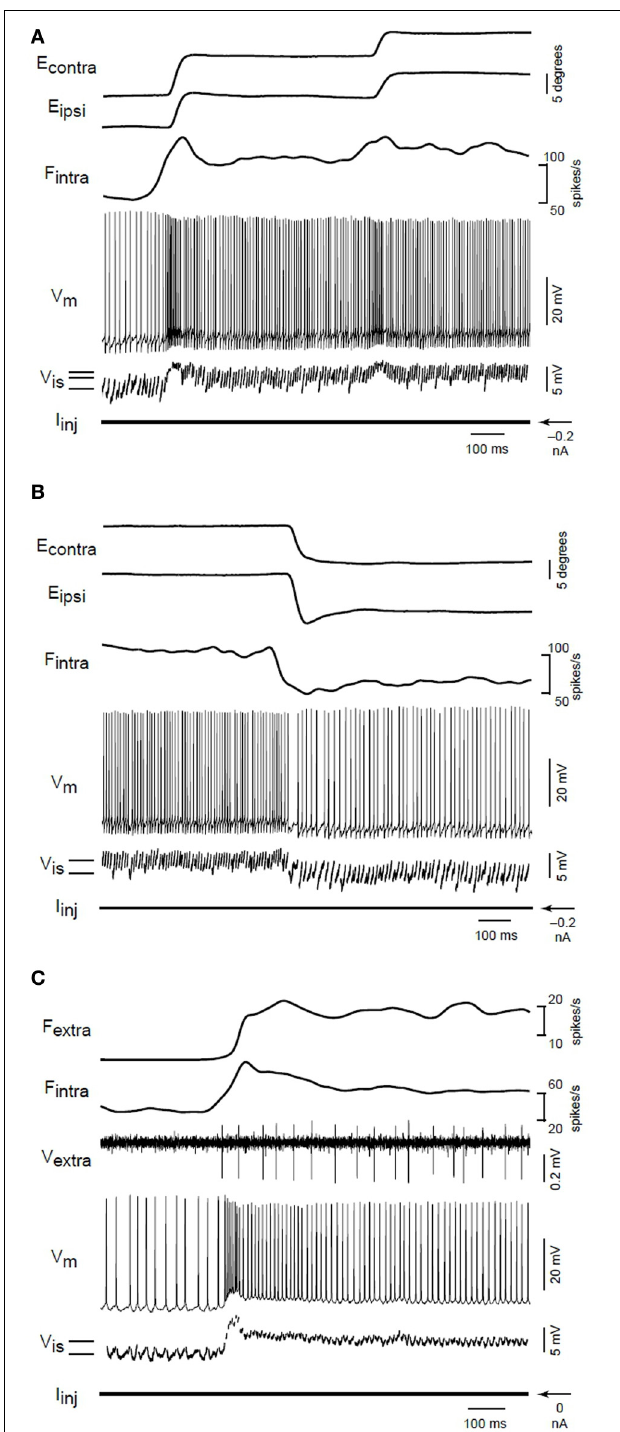
FIGURE 7 | From the original; Membrane potential changes during transitions in fixation position. (A) Eye position, firing rate of an intracellularly recorded neuron ( F intra ), membrane potential ( V m ), interspike membrane potential ( V is ), and injected current ( I inj ) for on-direction steps during intracellular recording. Solid lines at lower left indicate the average value of V is during separate fixations. (B) Changes during off-direction steps